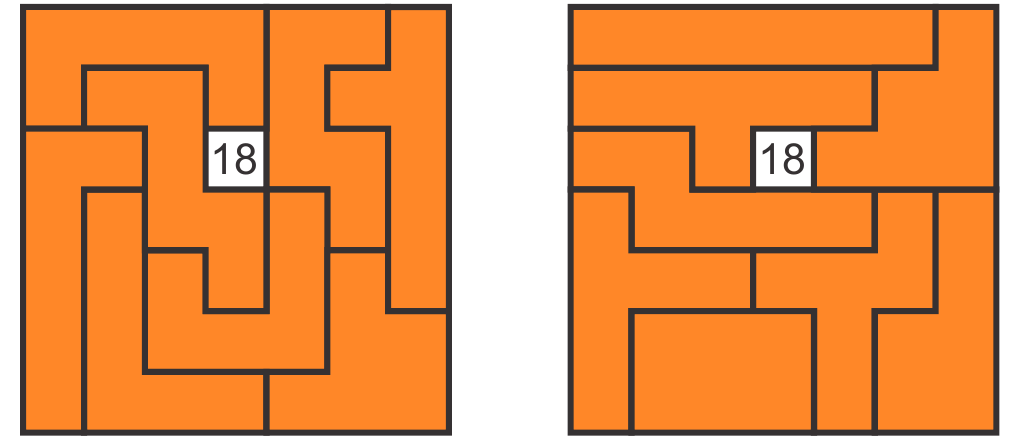
Figure 15. Original instructions for solution filed 18 ( left —1st level, right —2nd level).